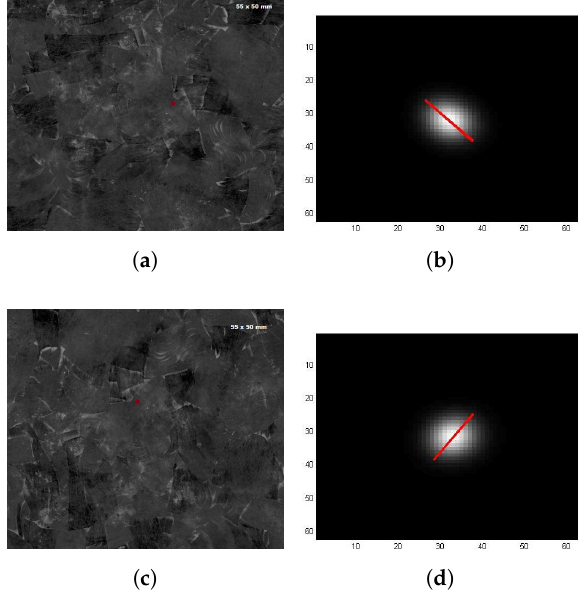
Figure 7. PTE inspection of single strand. First strand: ( a , b ) plate on its original position; and ( c , d ) plate rotated 90 ◦